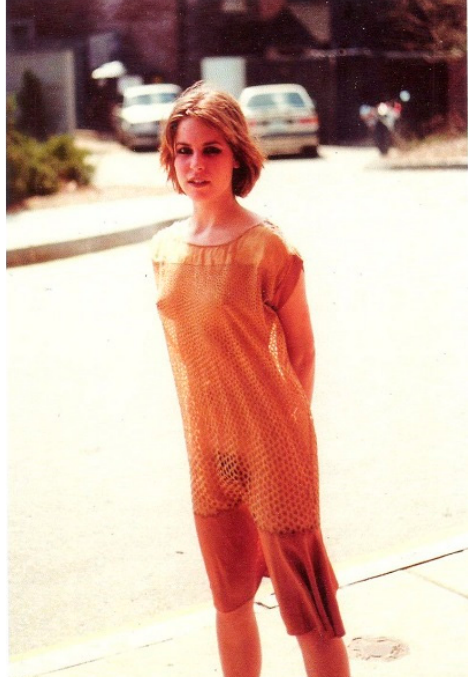
Figure 16. Lisa “Suckdog” Carver, 1987. Photo by Rachel Suckhorse. For Carver, it is not a question of reproducing the same musical and performative pat- terns established by male artists since the 1960s but of offering an alternative creative space for women in sound and visual experimentation. The pieces that Lisa Carver developed with Costes are also based on an instrumentalization of their own fears and traumas. The exploration of these psychologising mechanisms reveals a desire to understand human activities and reactions in their entirety, which leads the duo to tackle themes similar to those of the industrial genre: “The first show we did together was called Murderer from Venus . We had both been abused children, and our shows replayed those scenes, drunk with our dreams of revenge. Jean-Louis associated more class consciousness, more hierarchy, and my contribution probably made it more unstable, both personally and mentally. We both ended up, in this show, and in all those that followed, naked and almost always wounded” (Carver 2012, p.